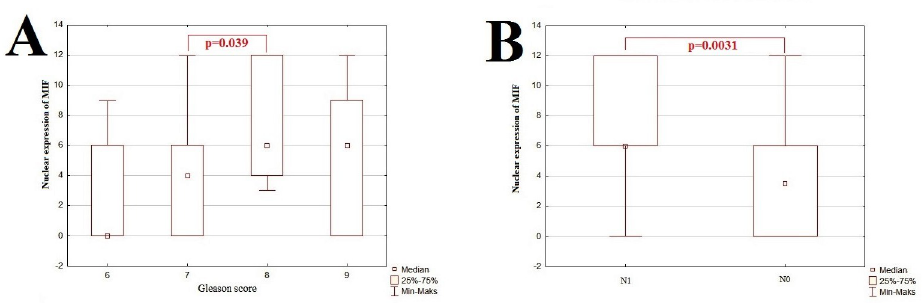
Fig 5. The graphic representation of results for nuclear expression of MIF examined by IHC technique. The x-axis shows individual clinicopathological features and the y-axis shows IRS score values for IHC staining. The p-value < 0.05 was considered as a statistically significant. Correlation between nuclear expression of MIF and Gleason score (A) and presence of the lymph node metastasis (B).